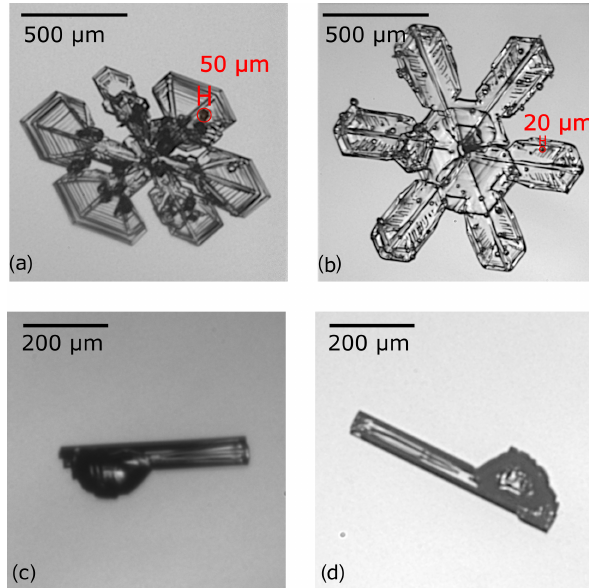
Figure 5. Exemplary slightly rimed particles showing the size of rime particles on the surface (a, b) and drizzle rimed ice (ice lollies, c, d ).